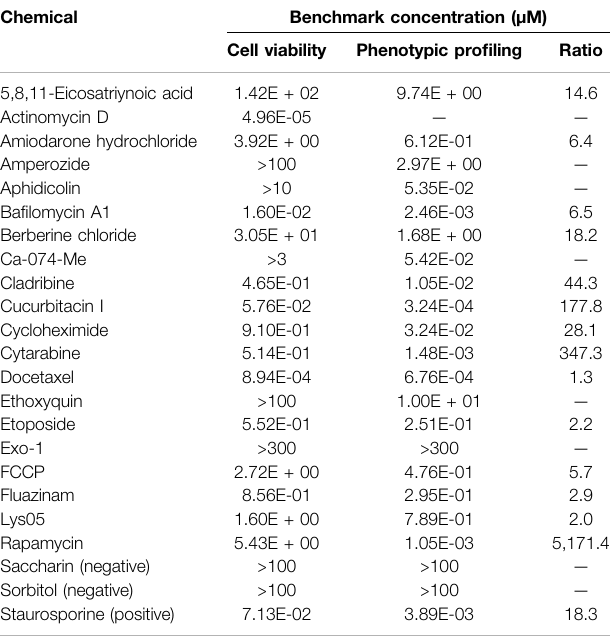
TABLE 2 | Benchmark concentrations for reference set chemicals.